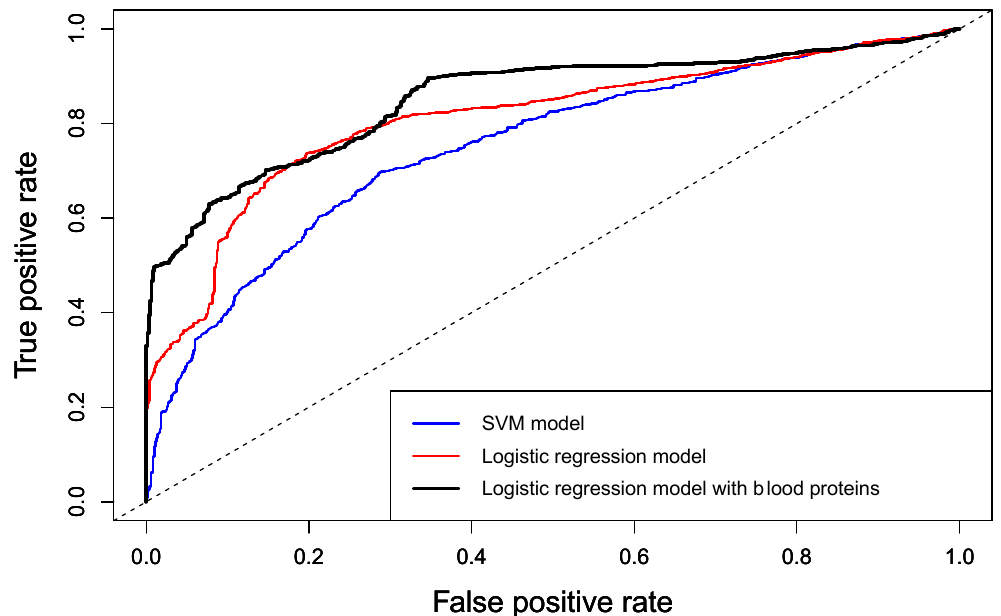
Figure 5. Average ROC curves for three different models, discriminating the positive vs. negative sMRI findings: (blue) Support vector Machine (SVM) model with metabolites, (red) logistic regression model with metabolites, and (black) logistic regression model with metabolites and blood proteins.